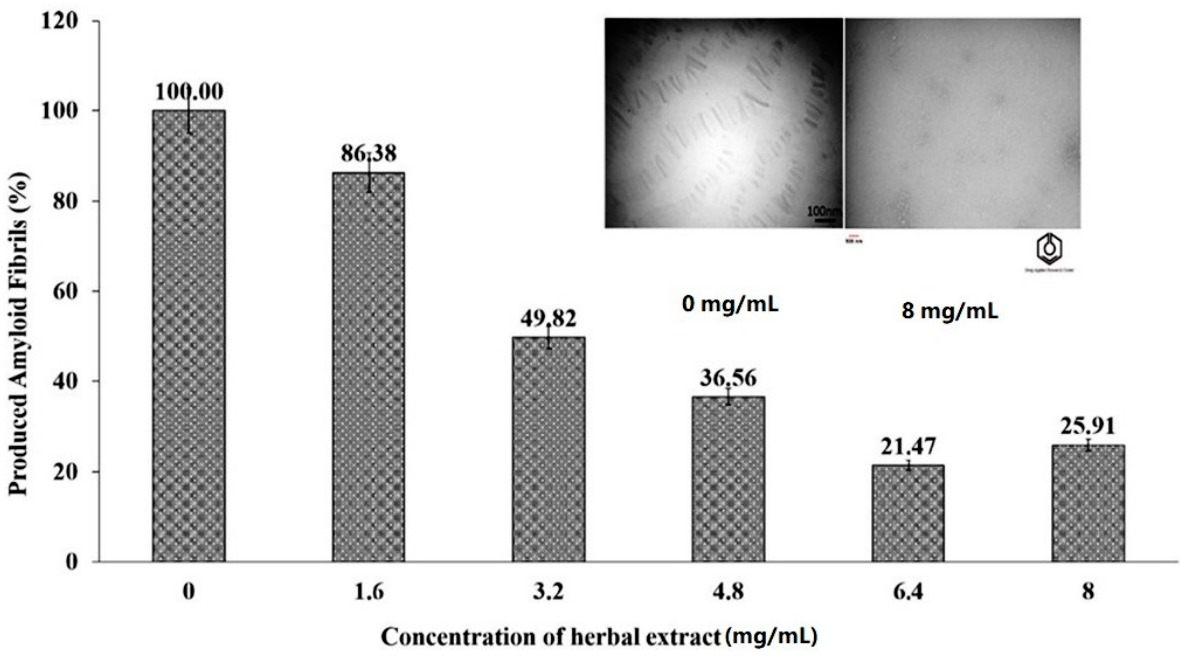
Figure 6. Produced amyloid fibrils (%) at different concentrations (0–8 mg/mL) of Citrus aurantium extract. Inhibition of amyloid fibrils is completely obvious in electron micrographs. Reprinted from [19] with permission from